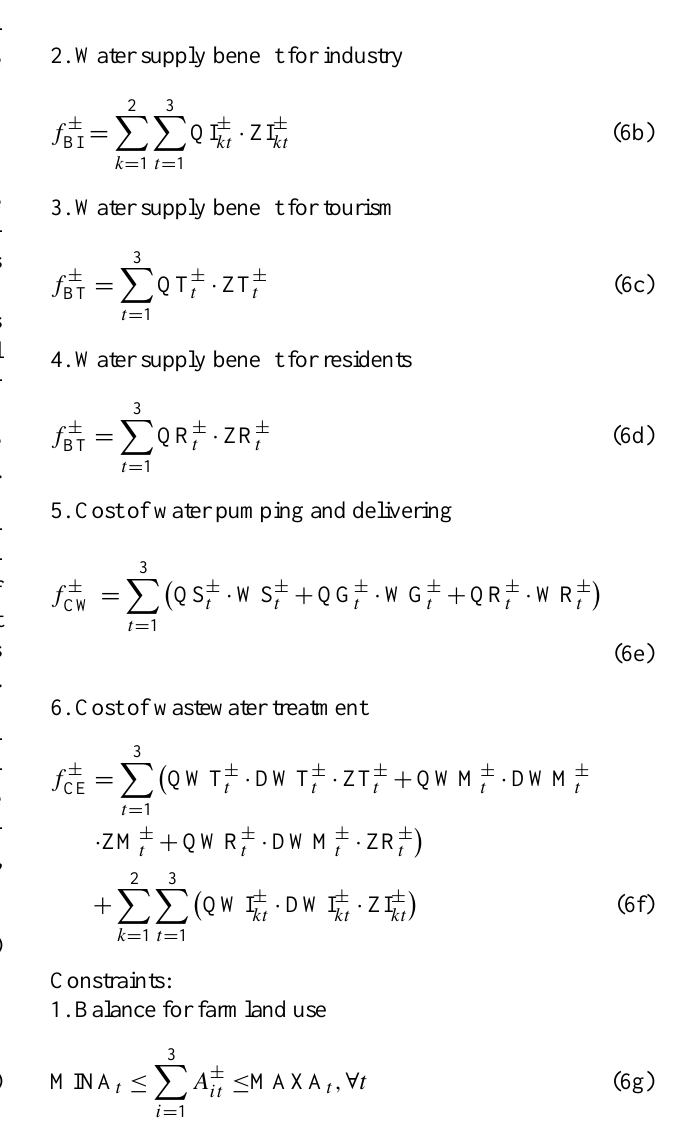
Fig. 3. The typical regional farmland use and water resources system